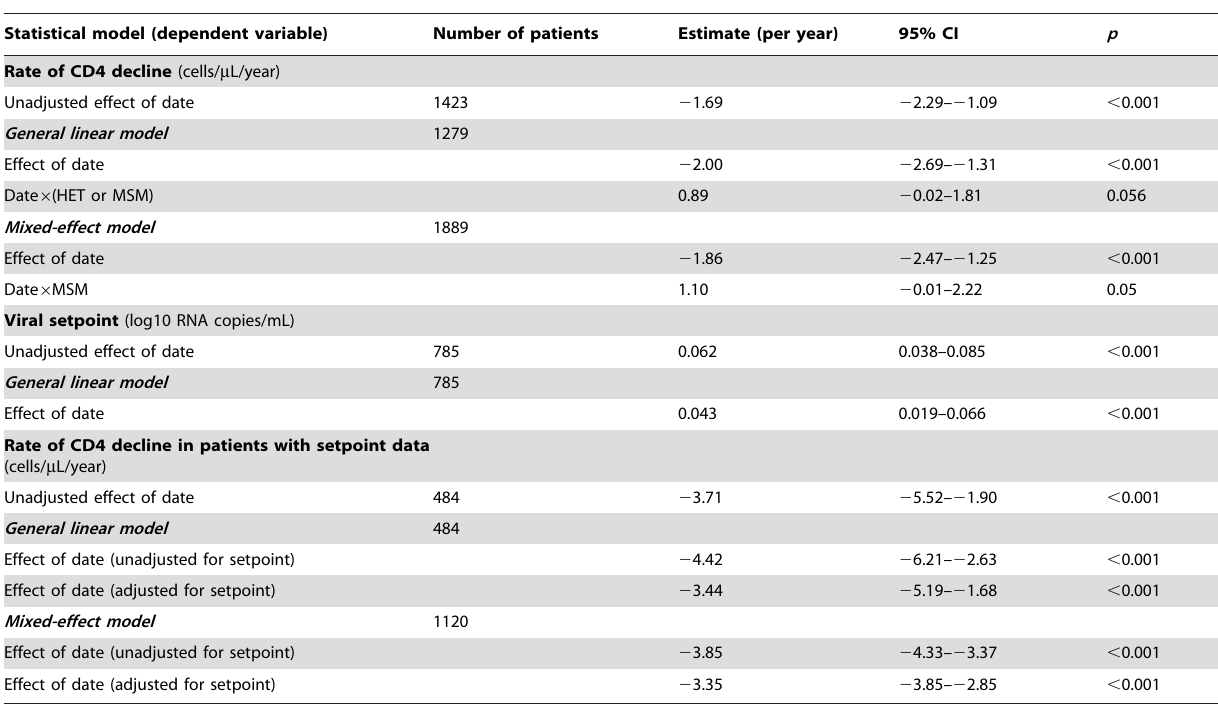
Table 2. Estimated effects of the date of confirmed infection on the markers of disease